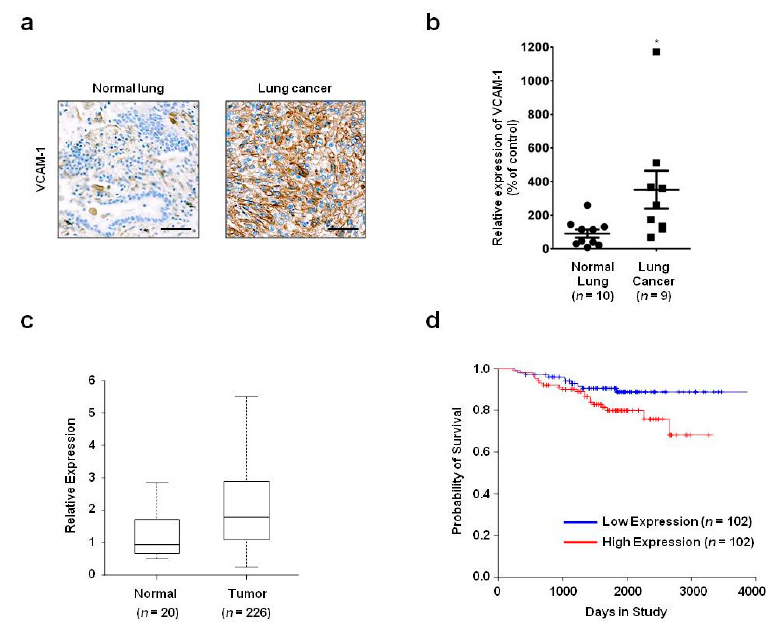
Figure 1. Expression and survival analyses of vascular cell adhesion molecule-1 (VCAM-1) in lung cancer patient samples. ( a ) Representative images are shown of the immnohistochemical examination of VCAM-1 in normal lung ( n = 10) and lung cancer ( n = 9) tissues using a commercially available anti-VCAM-1 antibody (scale bar = 200 µm); ( b ) A dot plot shows quantification of the immunohistochemical analyses of VCAM-1. Each dot represents the average of VCAM-1 expression levels quantified from three independent areas/sample. The values represent the mean ± SEM of the VCAM-1 expression calculated from each sample (* p < 0.05); ( c ) A box plot illustrates the results from VCAM-1 expression analyses that was performed with lung cancer patient gene expression profiling data obtained from the NCBI Gene Expression Omnibus database; ( d ) A Kaplan–Meier plot shows the overall survival of lung cancer patients classified by their VCAM-1 expression level (red: high expression group, n = 102; blue: low expression group, n = 102).